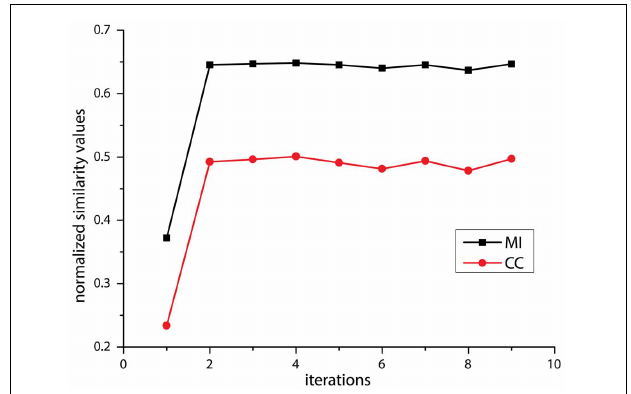
FIGURE 3 | Diagram of mean value of similarity value change using Normalized Cross Correlation (NCC, red) and Normalized Mutual Information (NMI, black) against the number of affine